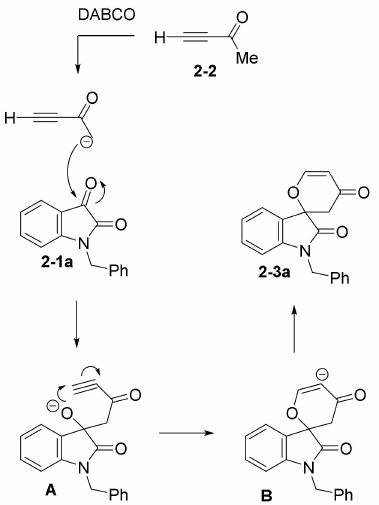
Scheme 4. Plausible mechanism for the synthesis of pyranones ( 2-3